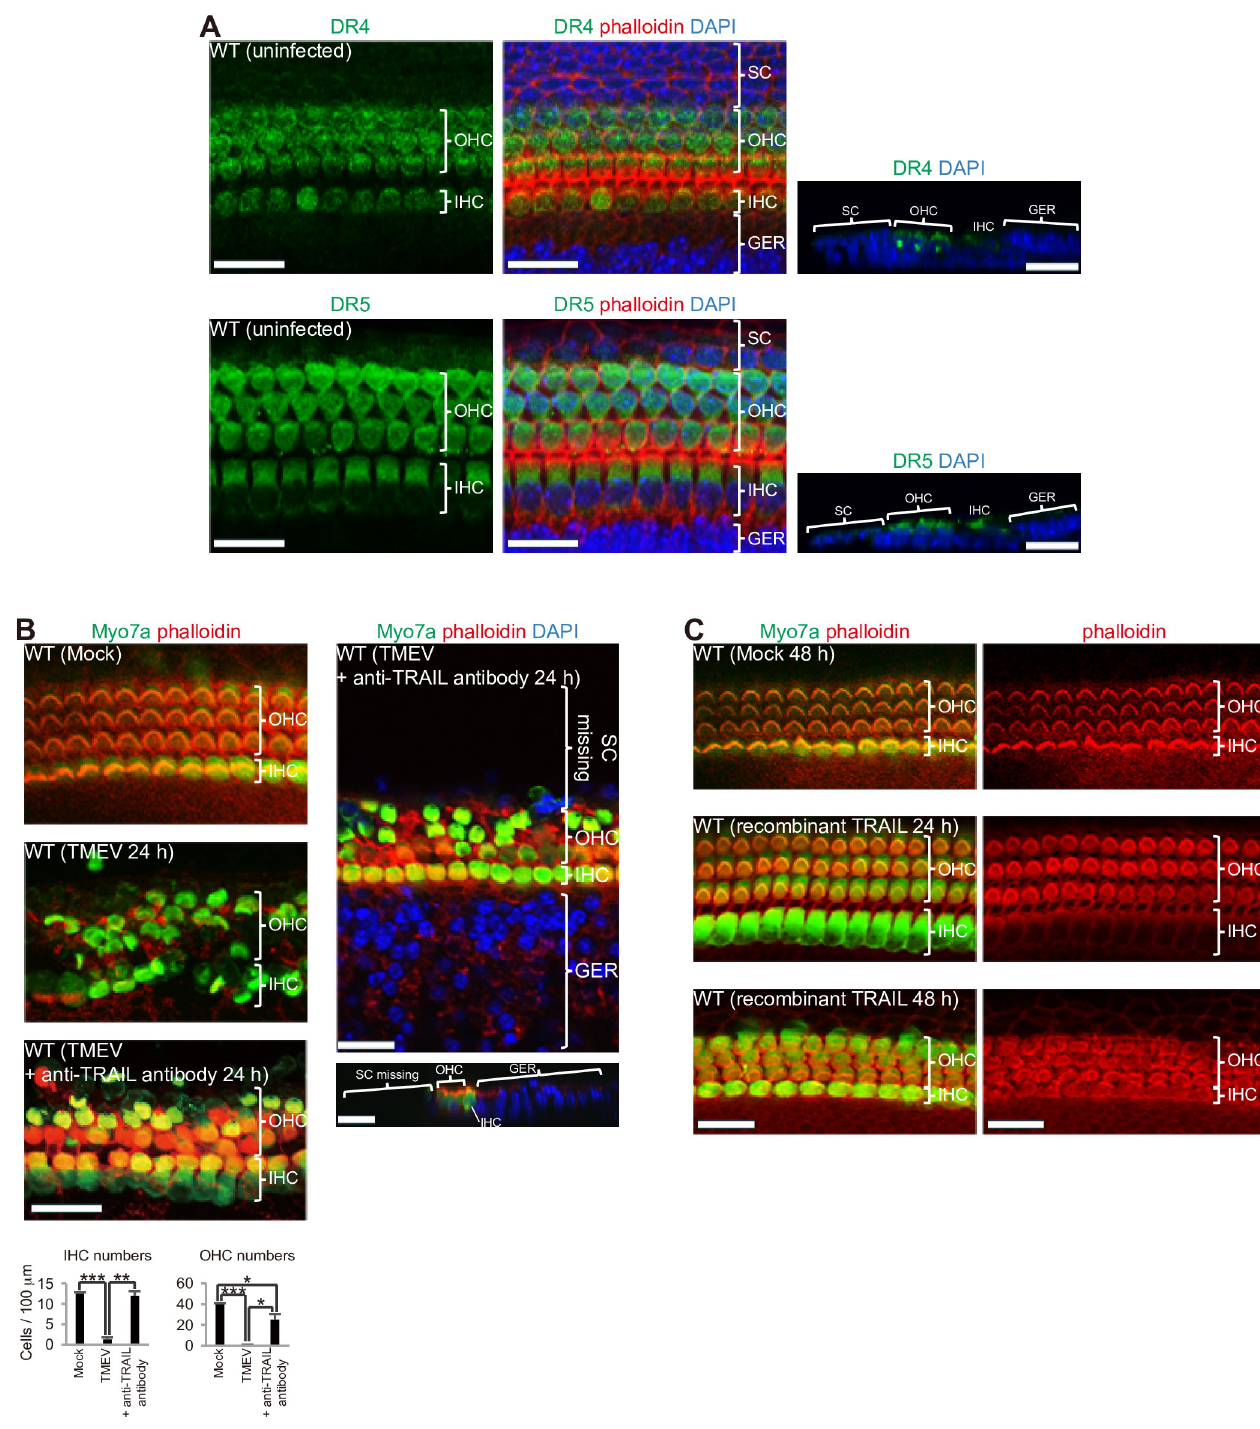
Fig 2. TMEV infection of SCs and GERCs results in TRAIL-mediated HC death. ( A ) HC expression of TRAIL receptors DR4 (green) and DR5 (green). ( B ) TRAIL-neutralizing antibody (5 μ g/ml) attenuated HC damage ( � P < 0.01, �� P < 0.001, ��� P < 0.0001, t -test, Mock: n = 6, TMEV: n = 4, + anti-TRAIL antibody: n = 3). While HCs were protected by anti-TRAIL antibody during TMEV infection, the death of SCs was not attenuated, indicating that the anti- TRAIL antibody has its effect directly on HCs. ( C ) Stereocilia of HCs was almost intact when treated with recombinant TRAIL protein (6 μ g/ml) for 24 h, but long term exposure to recombinant TRAIL protein (48 h) disorganised and deformed the stereocilia. Scale bars, 20 μ m. Error bars, standard errors.